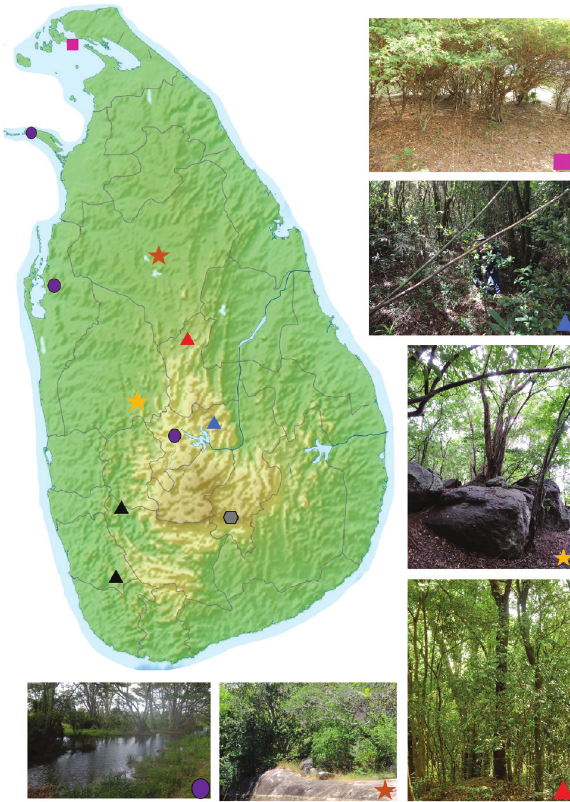
Figure 21. Distribution map of new species.  Cavisternum bom n. sp.;  Grymeus dharmapriyai n. sp.;  Pelicinus snooky n. sp.;  Pelicinus tumpy n. sp.;  Silhouettella tiggy n. sp.;  Silhouettella snippy n. sp.;  Silhouettella saaristoi n. sp.;  Ischnothyreus chippy n.